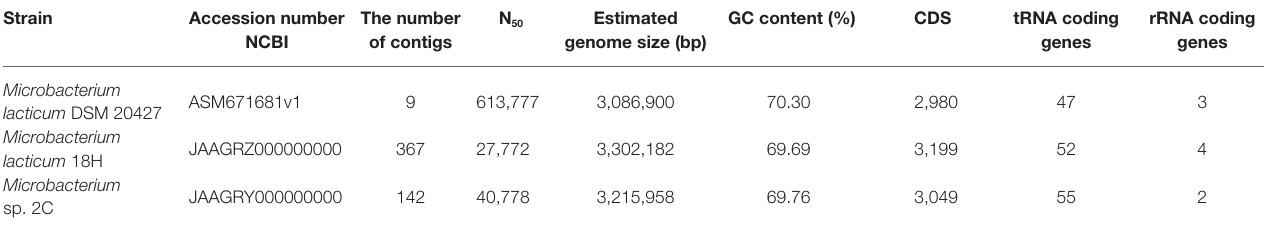
TABLE 1 | General features of the three genomes of Microbacterium . Strain The number